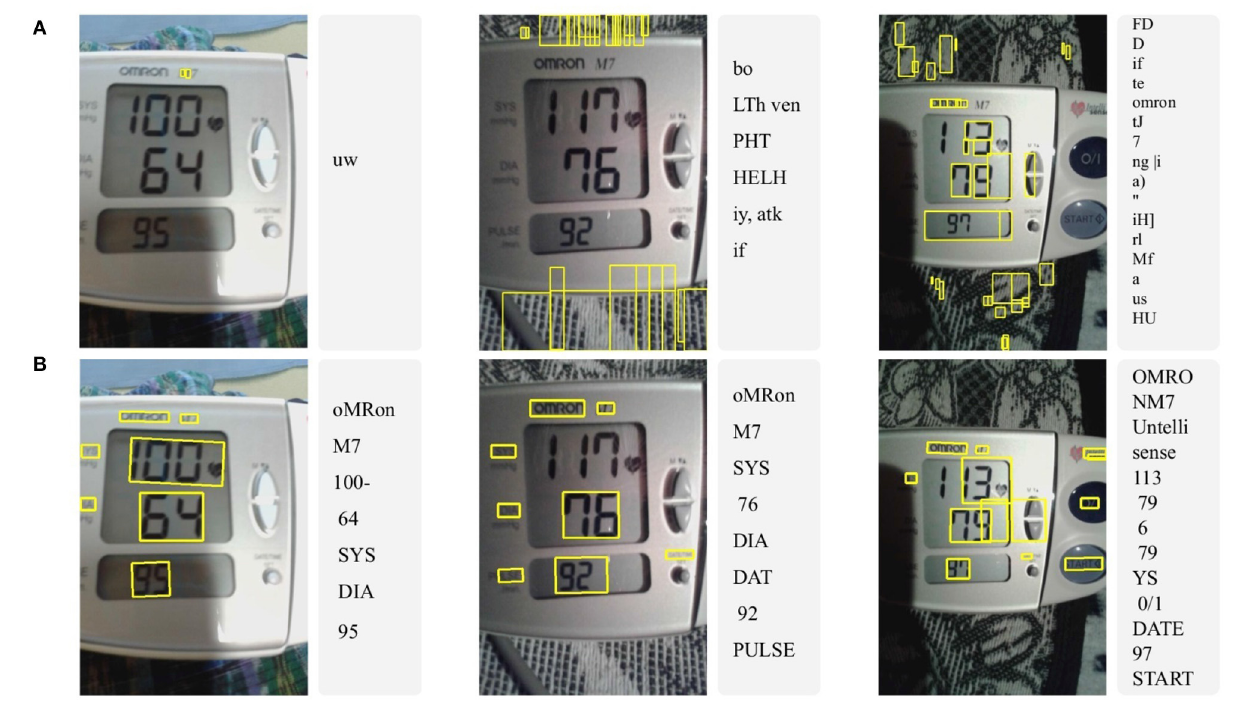
FIGURE 8 | Three typical examples of optical character recognition (OCR) results using (A) Tesseract and (B) Google vision API on original (raw) good-quality images. Notice the significant errors produced by Tesseract with overwhelming false positive and negative detections, resulting in no useful information. The Google